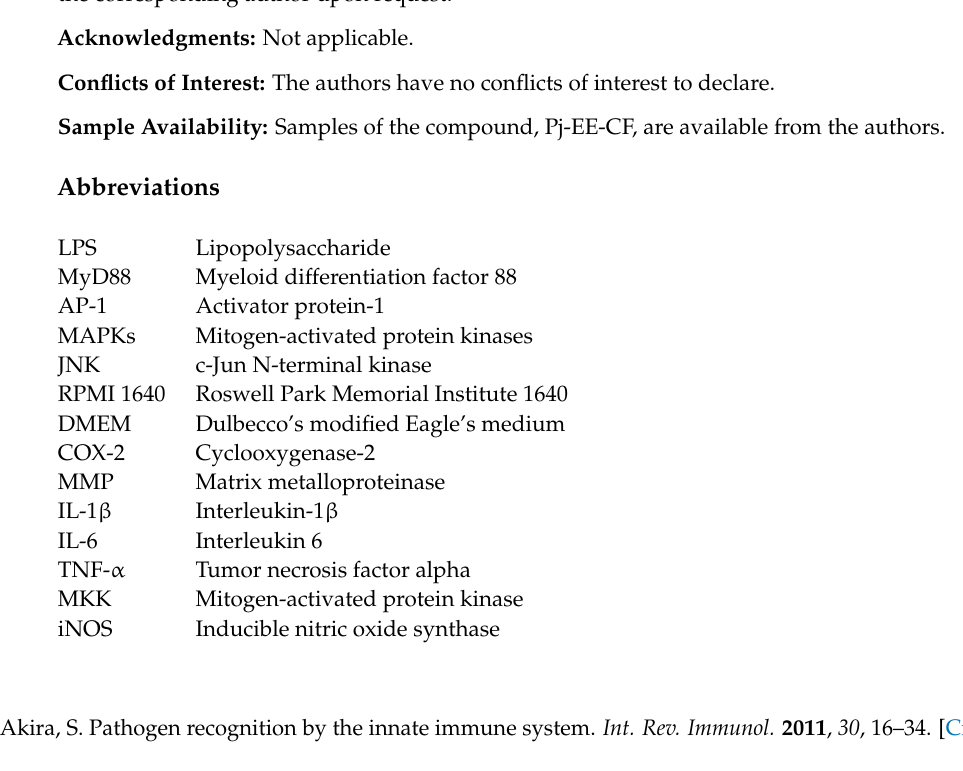
Supplementary Materials: Supplementary Table S1: LC-MS/MS of